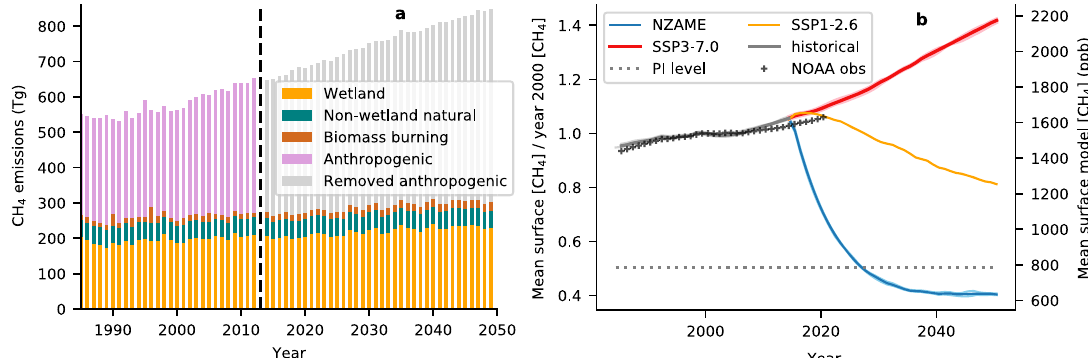
Fig. 1 Methane emissions inputs and the resulting surface methane concentrations in UKCA-CH4. a Methane emissions used as inputs into UKCA-CH4 for 1985 – 2050, from Gidden et al. 23 . The emissions are split into sectors: interactive wetland emissions (orange), non-wetland natural (green), biomass burning (dark orange), anthropogenic (pink) and removed anthropogenic in the zero anthropogenic methane emissions scenario (ZAME, grey). b Methane surface concentrations from 1985 to 2050 relative to the year 2000 (left-hand y axis). The right- hand y axis shows the corresponding modelled absolute methane concentration. Historical model concentrations are in dark grey and observations (Dlugokencky, NOAA/GML (gml.noaa.gov/ccgg/trends_ch4/) are shown by crosses. Three future scenarios are shown: ZAME (blue), SSP3-7.0 (red) and SSP1-2.6 (orange). The pre-industrial (PI) level is shown by the dotted line. The fainter coloured lines show the three individual ensemble members and the darker line shows the ensemble mean, for SSP3-7.0 and